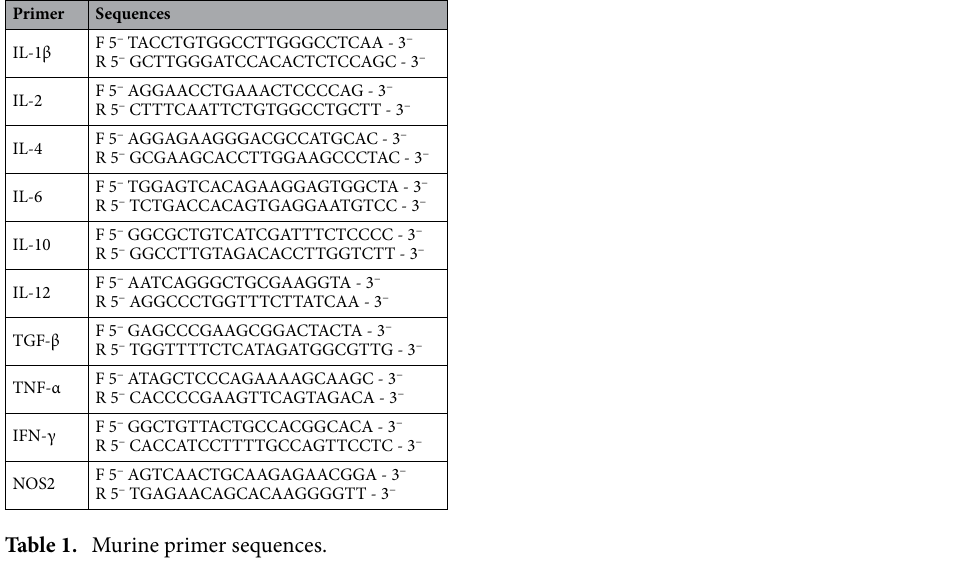
Given data are provided as means ± SEM. All data were tested for significance using unpaired Stu- dent’s t-test or ANOVA (one way & two ways). Data were analyzed by Excel 2010 or GraphPad Prism Software, USA. A value of P value ≤ 0.05 was statistically significant. For further details please see Supplementary Tables, where the significance of time and group factor are displayed for all experiments.